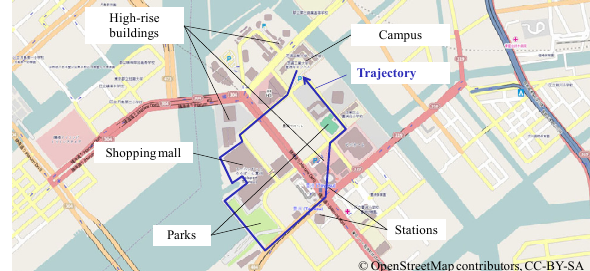
Figure 4. Study area (outdoor)